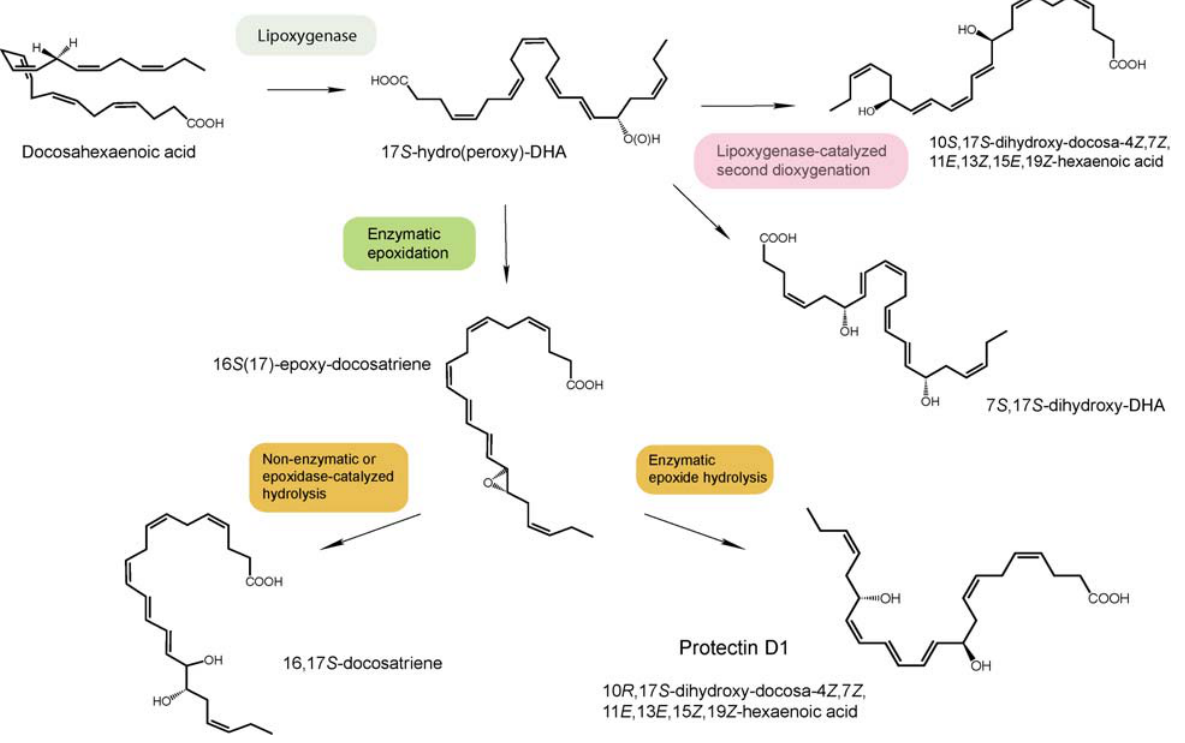
FIGURE 4 . Biosynthesis of PD1. 17 S -Hydroperoxy-DHA, generated by oxygenation of DHA, can also be transformed to a 16 S (17)-epoxy- docosatriene intermediate that, via hydrolysis, leads to the formation of a 10 R ,17 S -dihydroxy-triene–containing lipid mediator named PD1, as well as a 16,17 S -docosatriene. A second lipoxygenation-catalyzed dioxygenation of 17 S -hydroperoxy-DHA leads to the formation of the double- dioxygenated 10 S ,17 S -dihydroxy geometric isomer of PD1, as well as 7,17 S -dihydroxy-DHA. Note that aspirin-acetylated COX-2 can oxygenate DHA to form 17 R -hydroperoxy-DHA allowing the generation of the corresponding 17 R- epimeric aspirin-triggered